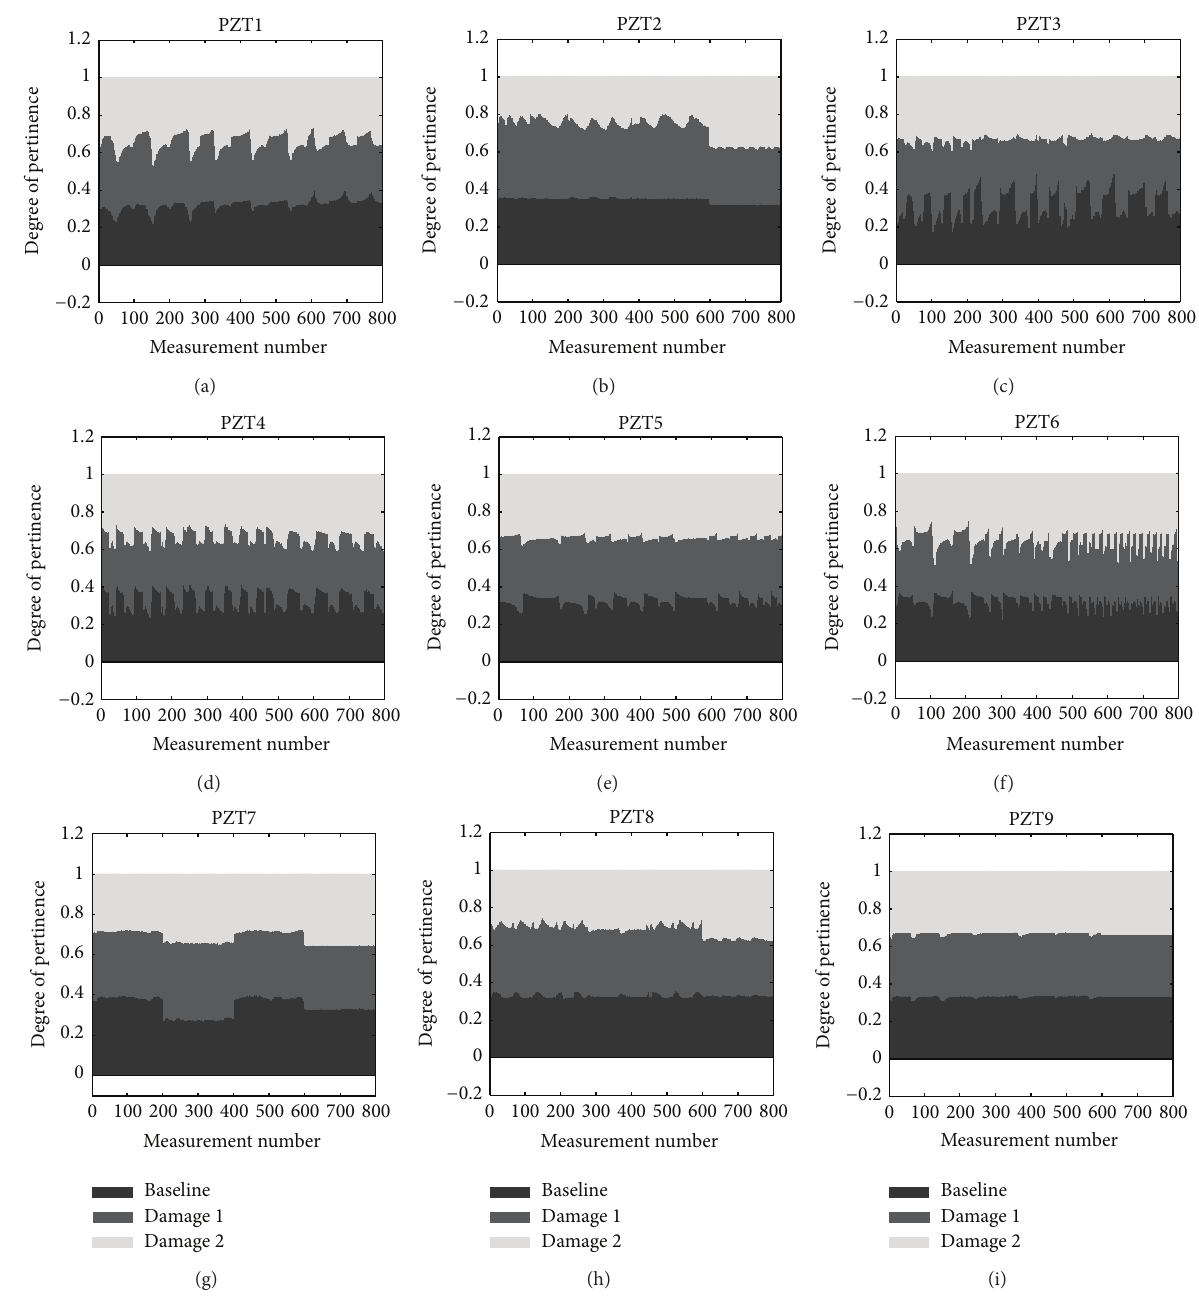
Figure 6: Initial degrees of pertinence for the aircraft